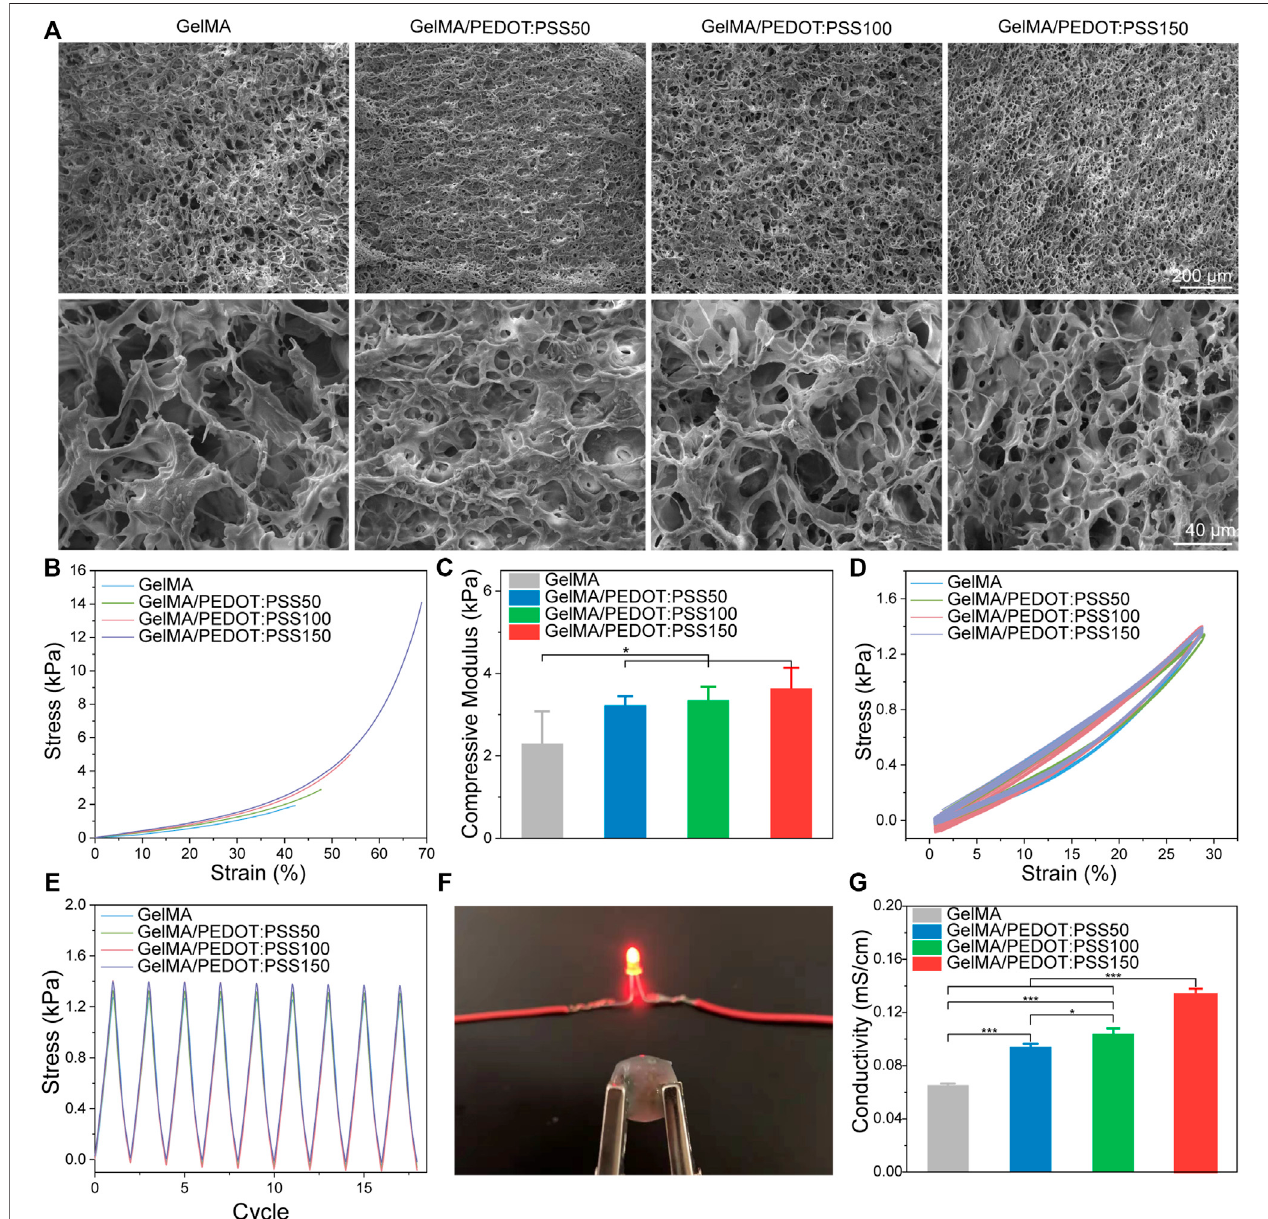
FIGURE 2 | Structural characterization and physical properties of GelMA/PEDOT: PSS hydrogels. (A) Internal porous morphology of GelMA/PEDOT:PSS hydrogels. (B) Representative compressive stress-strain curves. (C) Compressive moduli of GelMA/PEDOT: PSS hydrogels. (D) Loading-unloading curves of GelMA/ PEDOT: PSS hydrogels at a strain of 30%. (E) Compressive stress was recovered to the initial state after repeated compression. (F) An LED bulb and GelMA/PEDOT: PSS100hydrogelformedaclosedcircuit. (G) TheconductivityofGelMA/PEDOT:PSShydrogels.Thedataareexpressedasmean±standarddeviation.* p < 0.05, ** p < 0.01, *** p <